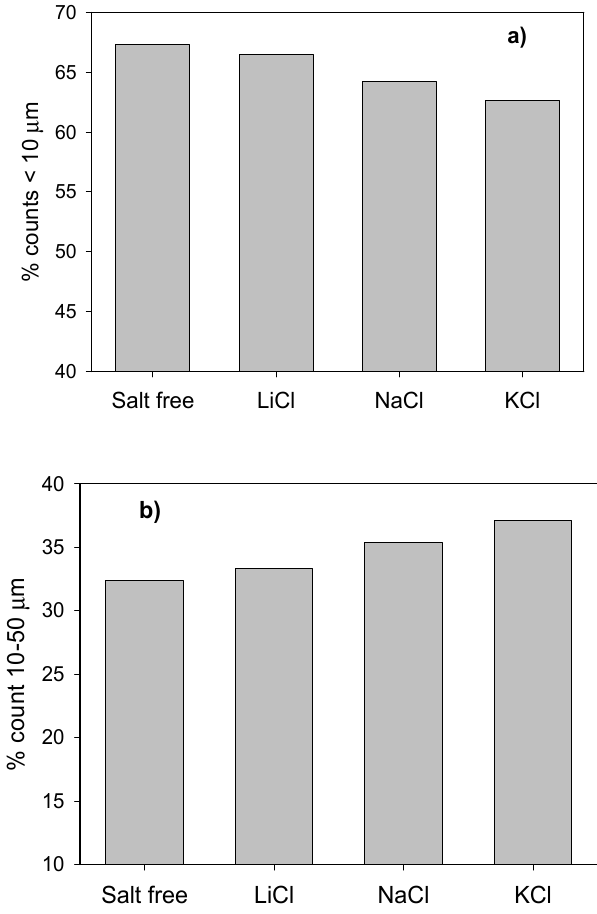
Figure 10. Distribution of silica particles classified into two segments: ( a ) counts < 10 µ m and ( b ) counts 10–50 µm.